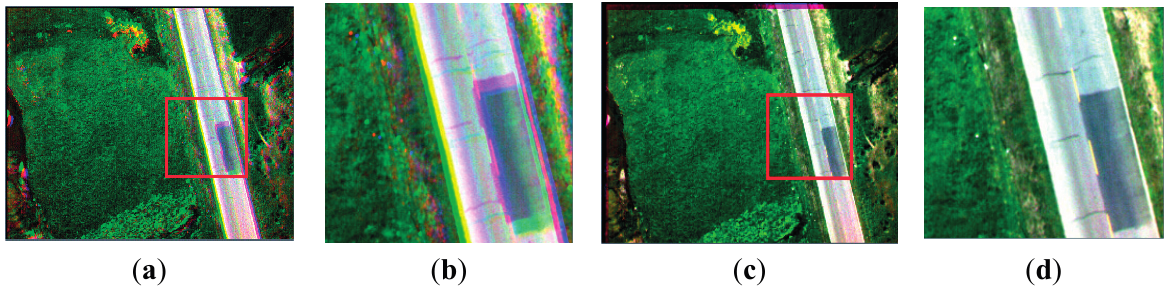
Figure 14. The true-color composite (red, green, blue); ( a ) the unregistered multispectral image; ( b ) the enlarged partial region of ( a ); ( c ) the registered multispectral image; ( d ) the enlarged partial region of ( c ).